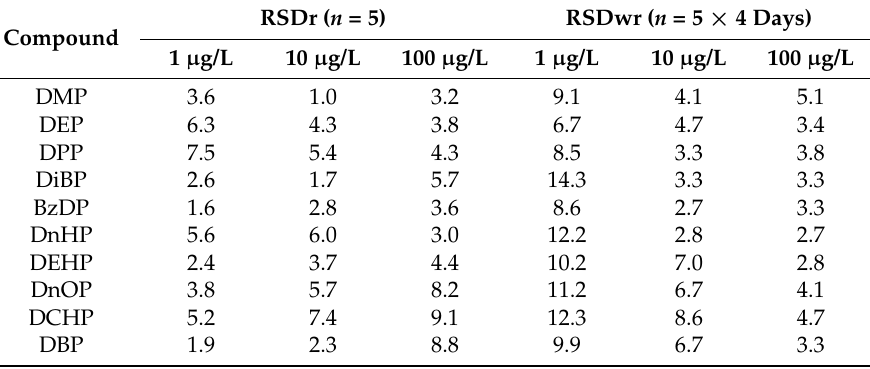
Table 5. Repeatability (RSD r ) and within-laboratory reproducibility (RSD wr ) for peak areas evaluated at three concentration levels.